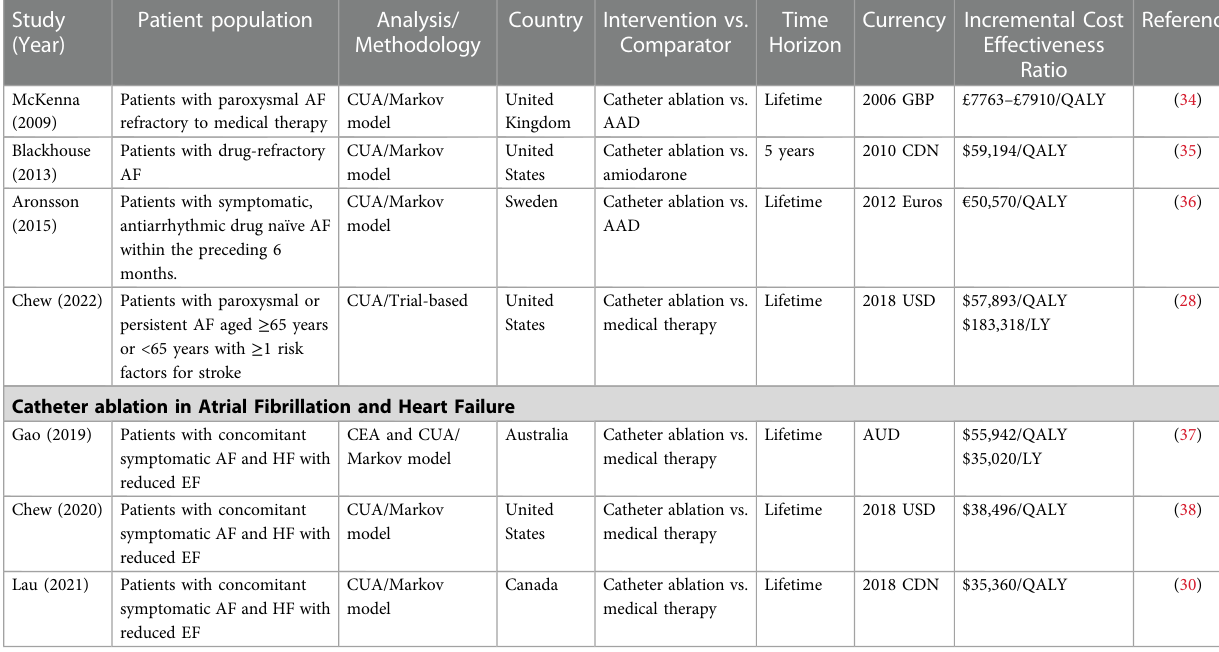
TABLE 2 Selected economic evaluations of catheter ablation for atrial fi brillation. Study